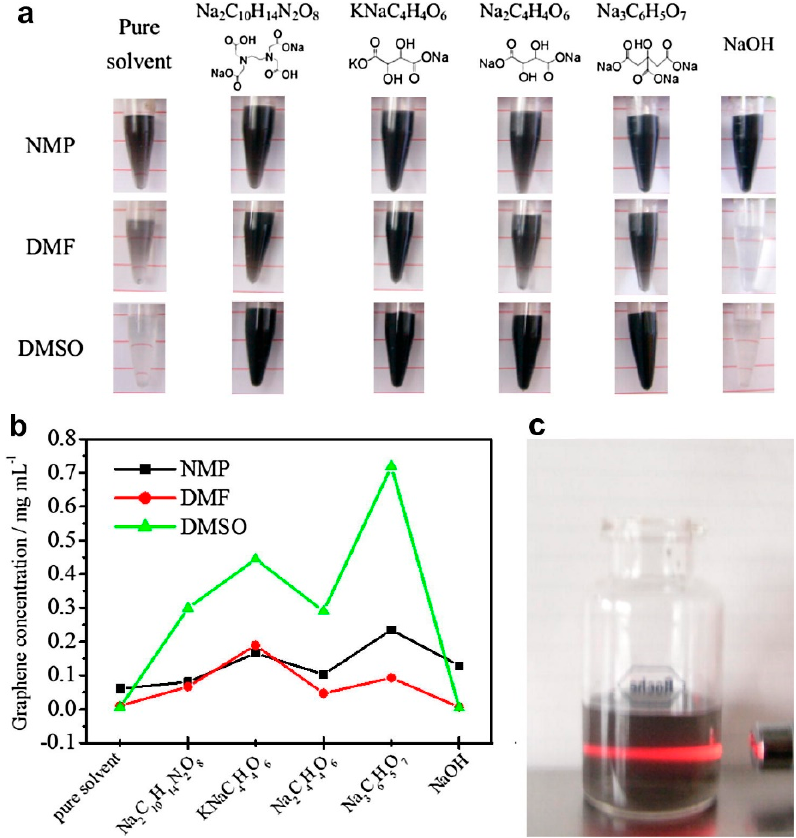
Figure 16. ( a ) Graphene sheets dispersed in organic solvents without or with various additives. ( b ) Concentrations of corresponding graphene dispersions in (a). ( c ) Tyndall effect exhibited by a diluted dispersion in DMSO passed through with red laser light. For interpretation of the references to color in this figure legend, the reader is referred to the web version of this article. Reproduced from [83]. Copyright Elsevier, 2013.